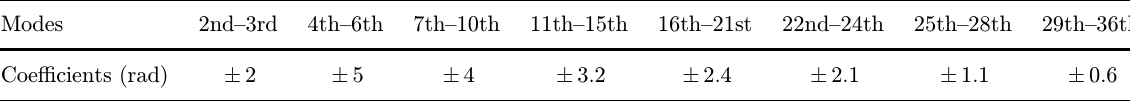
Table 1. The coe±cient ranges of 2nd (cid:4) 36th Zernike modes.